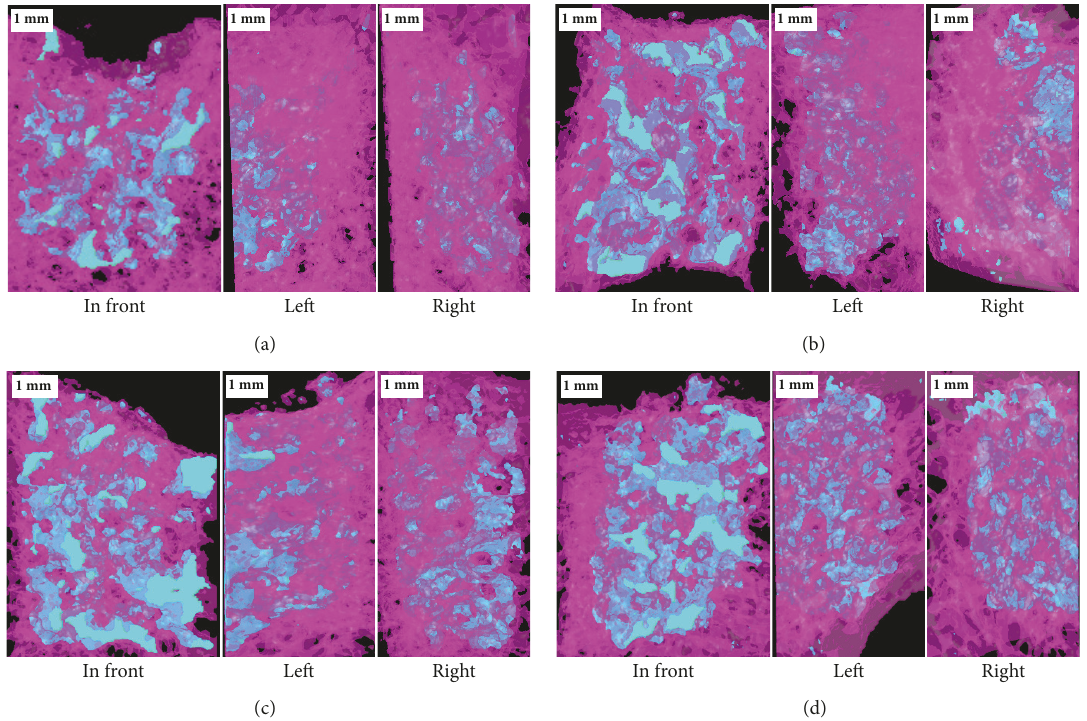
Figure 7: Micro-CT images at 24 weeks after implantation: (a) 40 TCP 3, (b) 1mM 40 TCP 3, (c) 5 mM 40 TCP 3, and (d) 10 mM 40 TCP 3.